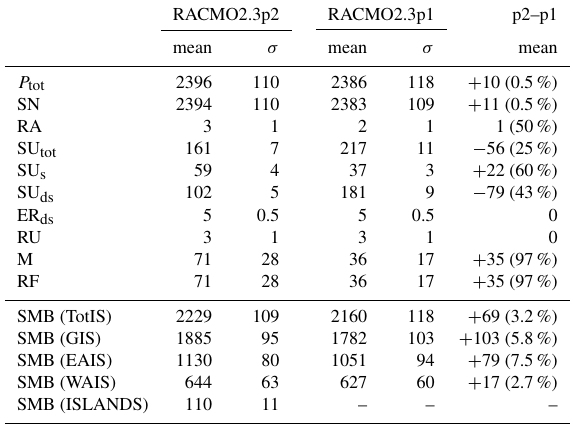
Table 2. Total ice sheet, including ice shelves and excluding the Antarctic Peninsula, integrated SMB mean 1979–2014 (the overlap- ping period for both model versions) values [Gty − 1 ] with interan- nual variability σ : total (snow and rain) precipitation ( P tot ), snow- fall (SN), rainfall (RA), total sublimation (SU tot ), surface sublima- tion (SU s ), drifting snow sublimation (SU ds ), drifting snow erosion (ER ds ), run-off (RU), snowmelt ( M ) and refrozen mass (RF). All values calculated on the RACMO2.3p2/ANT ice mask (Bamber et al., 2009). EAIS, WAIS and ISLANDS SMB are based on the Rig- not et al., (2018) drainage basins and denote the grounded ice sheet. No values for RACMO2.3p1/ANT are given for the latter region; as they do not correspond with the RACMO2.3p1 ice mask